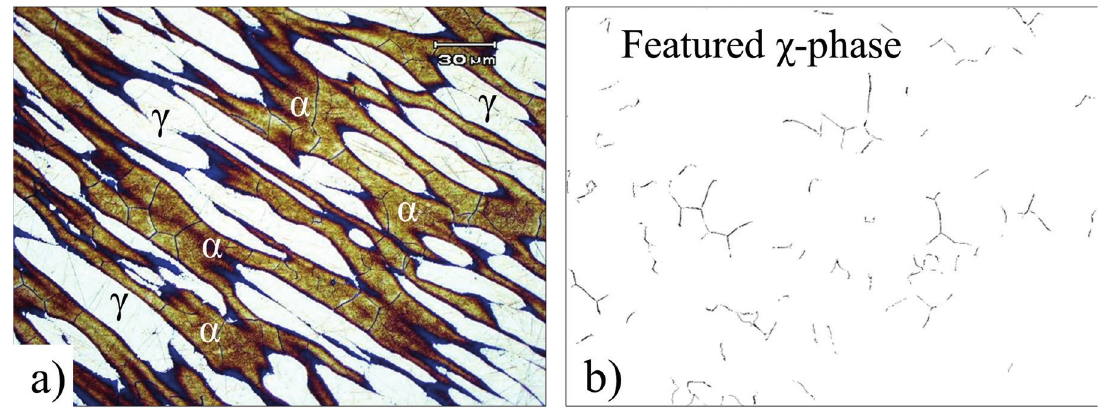
Figure 11: Microstructure of referred result used for measure % intermetallic phases according DNV-RP-F112 30